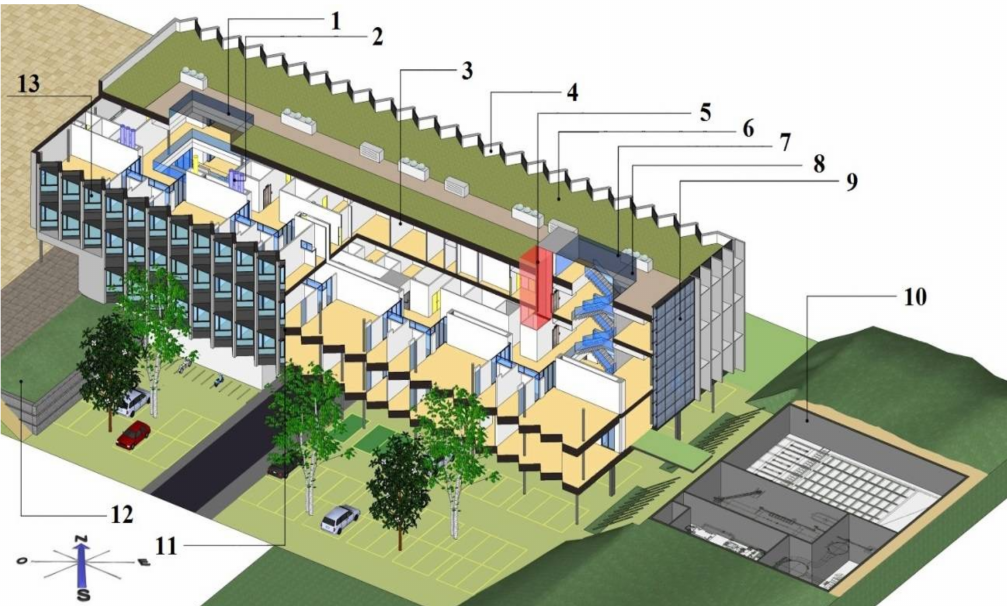
Figure 8. Artist impression of the 3D ZEB LUCIA; 1 . photovoltaic cells skylight; 2 . natural lighting devices; 3 . control lighting; 4 . photocatalytic tiles; 5 . energetic regeneration lift and sleep system; 6 . green roof; 7 . photovoltaic cells skylight; 8 . atrium; 9 . photovoltaic courtain Wall; 10 . CHP; 11 . lack of thermal bridge; 12 . geothermal tubes á rea; 13 . auto-shading